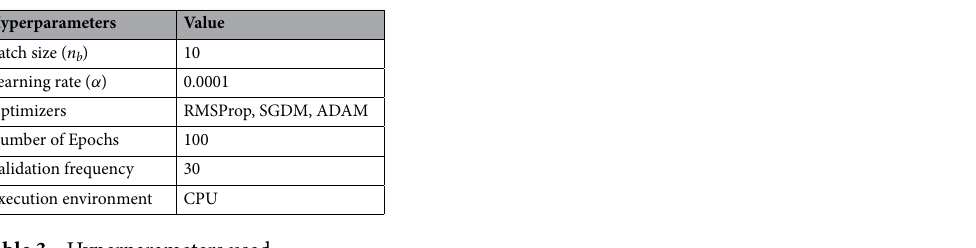
Table 3. Hyperparameters used.